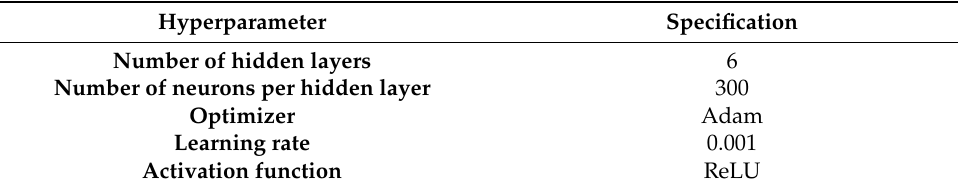
Table 3. Hyperparameters.